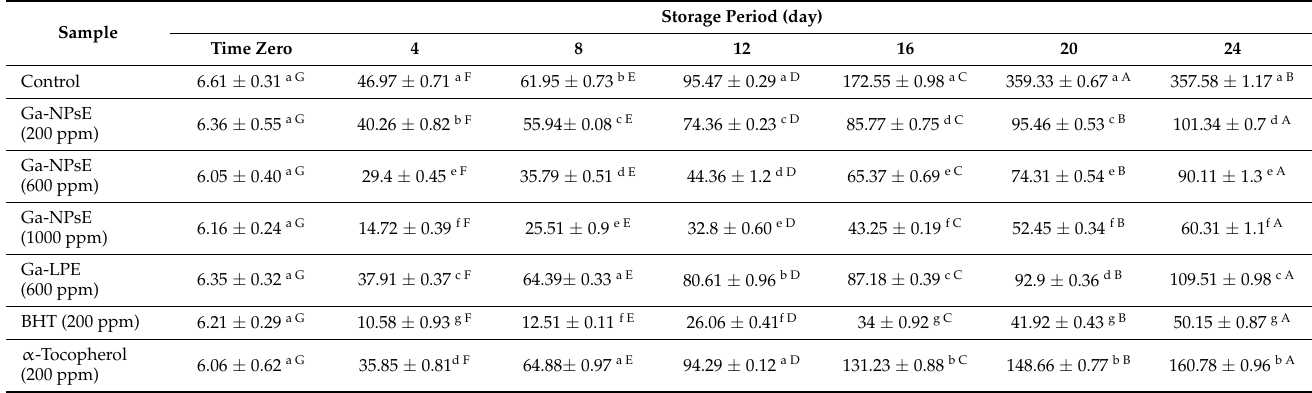
Table 3. Effect of garlic nanoparticle extracts on the totox value (meq kg − 1 ) of SFO during storage at 65 ◦ C (mean ± SD, n =